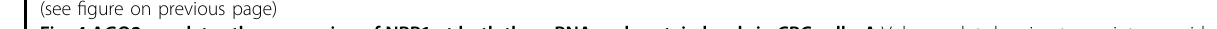
Fig. 4 AGO2 regulates the expression of NRP1 at both the mRNA and protein levels in CRC cells. A Volcano plot showing transcriptome-wide differences in RNA-seq expression data upon AGO2 knockdown. B Venn diagram showing the overlap of RNA-seq expression data upon AGO2 knockdown or AGO2 knockout. C GSEA of the transcriptome pro fi les shows a highly signi fi cant enrichment of EMT-induced gene signatures after AGO2 knockdown (upper) or knockout (bottom). D The expression of differential genes was determined by qRT-PCR. E Volcano plot showing protein differences in quantitative proteomic data upon AGO2 knockdown. F GO enrichment analysis of differential expressed proteins. G Heatmap of differentially expressed proteins after AGO2 knockdown. H . Western blotting analysis of the upregulated oncogenes upon AGO2 knockdown. Data are shown as the mean ± SD. ns ( p > 0.05), * p < 0.05, ** p < 0.01, *** p < 0.001, and **** p <